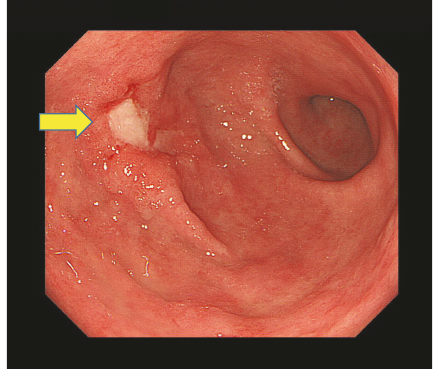
Figure 2: Esophagogastroduodenoscopy revealed an infiltrative ulcerative carcinoma (arrow) in the anterior wall of the antrum of the patient’s